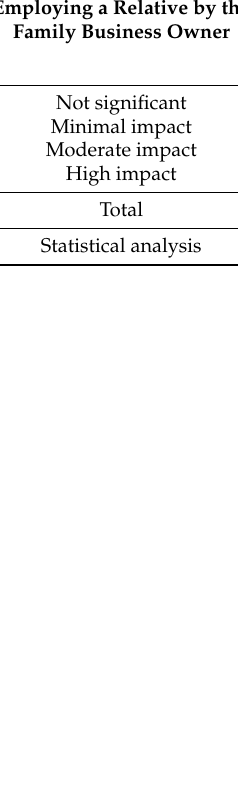
Table 8. Statistical analysis of the assessment of the impact of the Covid pandemic on employing a friend by the manager responsible for recruitment in the organization depending on the